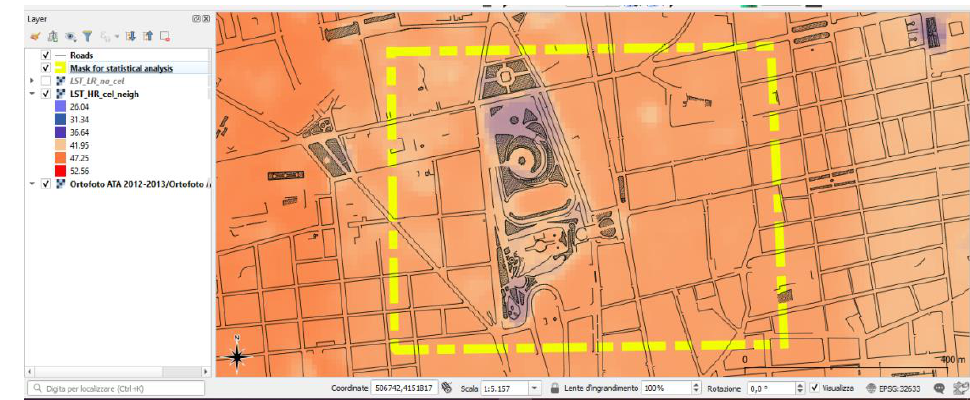
Figure 6. Area subjected to statistical analysis.